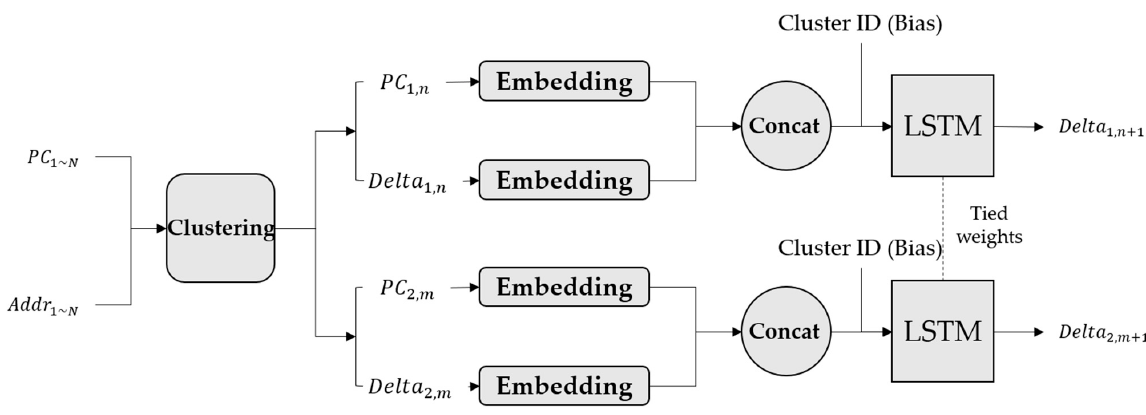
Figure 12. The Clustering + LSTM Model [14].